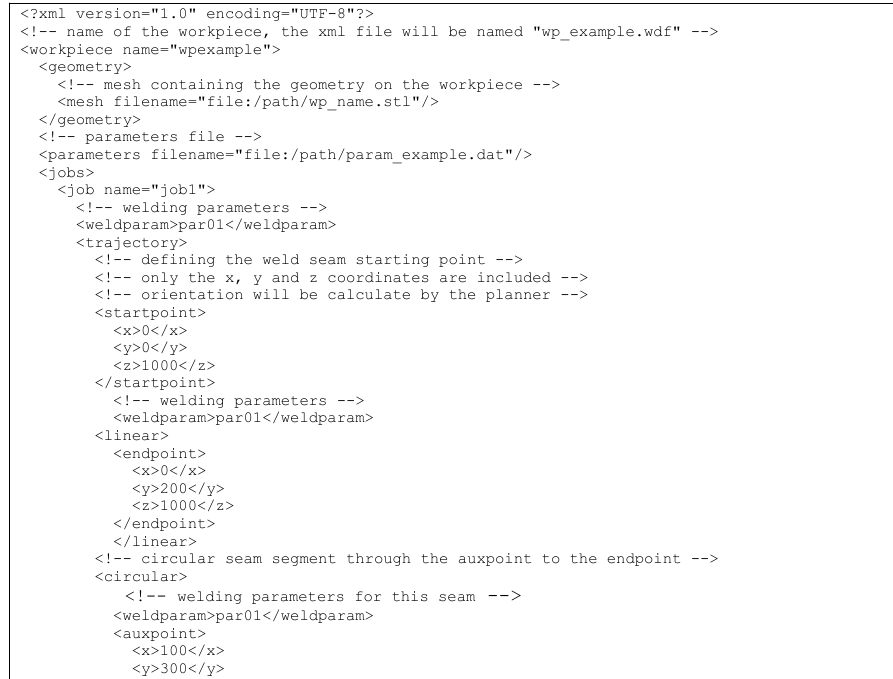
Figure 1. XML-based job description.